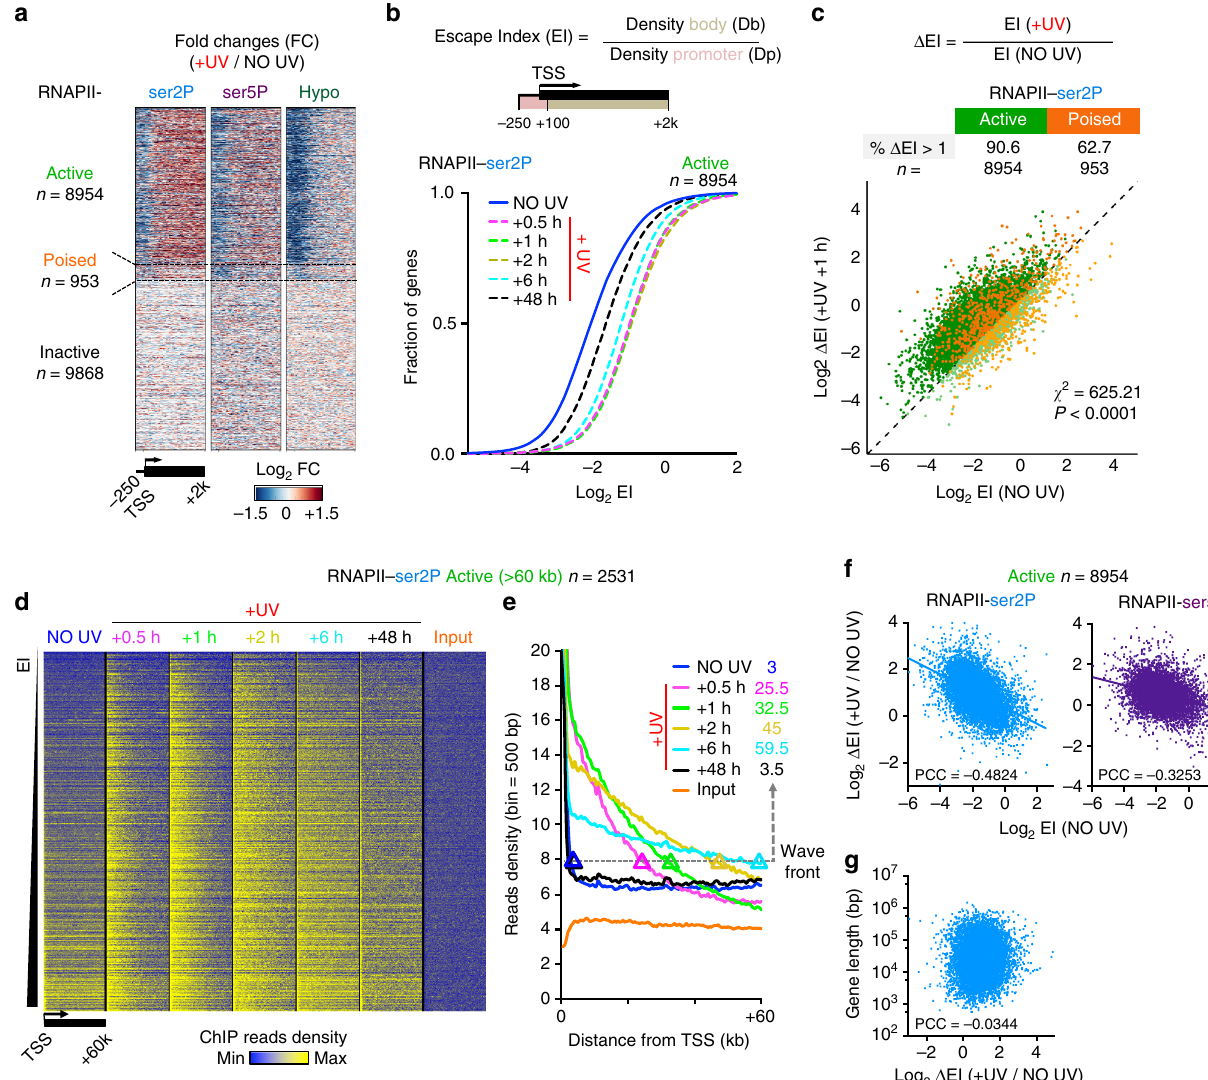
Fig. 1 Global triggering of transcription waves on virtually all active genes in response to UV irradiation. a Heatmaps illustrating the Log 2 fold change (FC) of main RNAPII isoforms comparing reads density (Rd) between UV irradiation (8 J m − 2 ) and steady-state (FC = (Rd +UV )/(Rd NO UV ), as aligned at individual (rows) regions ( − 250 bp to +2 kb relative to TSS) and categorised by gene expression status (see Supplementary Fig. 1). b RNAPII Escape Indexes from promoter regions (EI) before and after UV plotted as empirical cumulative distribution of fraction (ECDF) of active (labelled in solid green throughout the paper) genes. EI represents the ratio of reads density in gene body over reads density in promoter. c Individual comparison of EI before and after UV for all active and poised genes. Percentages of genes with increased escape after UV ( Δ EI > 1, dark green dots) are shown. Chi-square test ( χ 2 ) determines whether observed number of genes with Δ EI > 1 differs from expected value purely by chance. P is indicated. d Heatmaps illustrating RNAPII- ser2P and Input read densities from TSS to TSS + 60 kb before and after UV, as aligned at individual (rows) active genes larger than 60 kb and ranked by increasing EI (as determined before UV in b ). e Average plots of read densities shown in d indicating progression of wave front position (kb) at arbitrary threshold representing the transition state (enriched to steady-state). f Correlation plot between constitutive EI (NO UV) for RNAPII-ser2P (left) or RNAPII-ser5P (right) and EI change after UV ( Δ EI(+UV vs NO UV)) for all active genes. PCC scores are indicated. g Same as in f for RNAPII-ser2P Δ EI (+UV vs NO UV) plotted against gene length